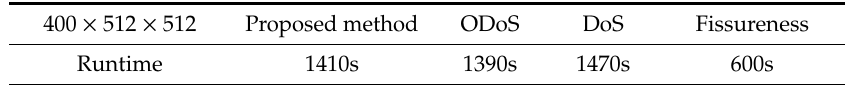
Table 1. The runtime of the proposed method, ODoS method, DoS method and fissureness method for a typical 400 × 512 × 512 size